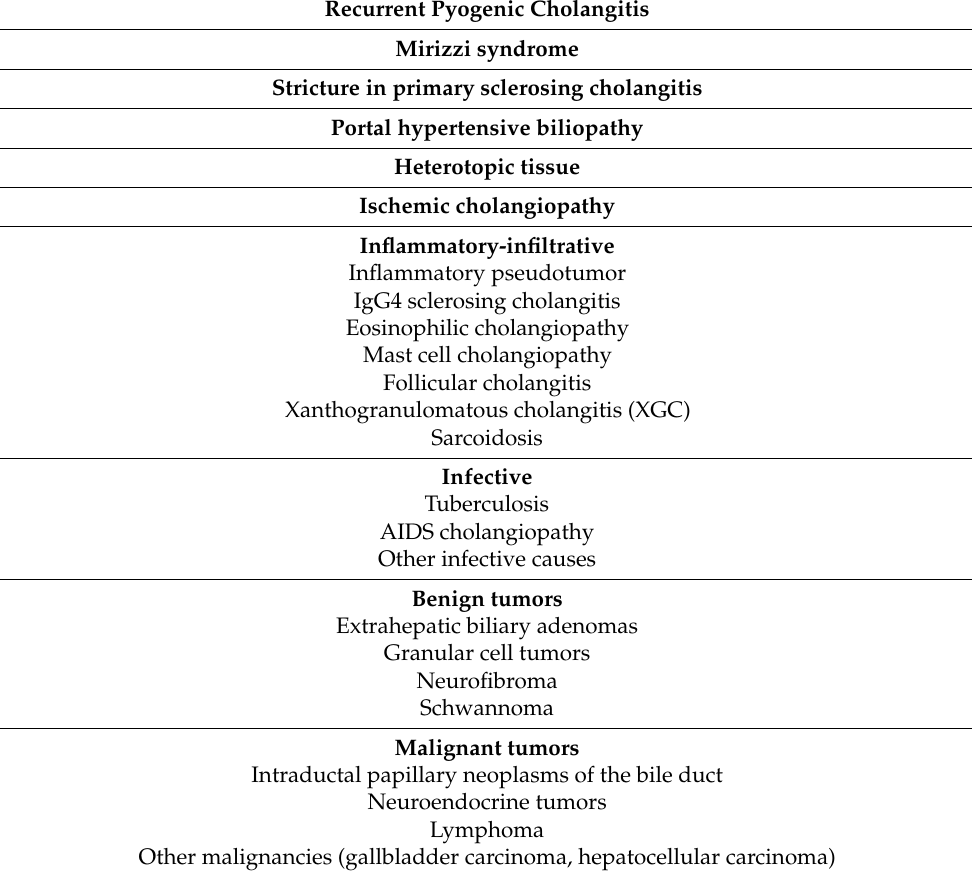
Table 1. Most common Klatskin-mimicking